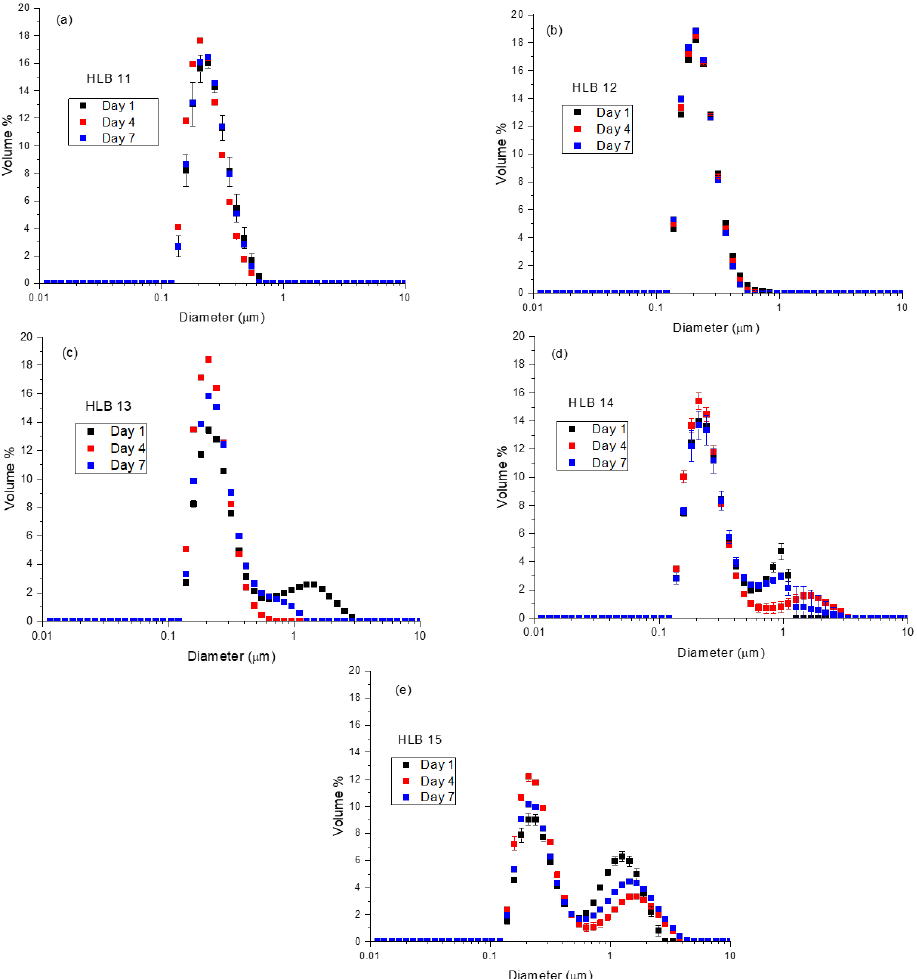
Figure 3. Droplet size distributions for emulsions with HLBs of ( a ) 11, ( b ) 12, ( c ) 13, ( d ) 14 and ( e ) 15 as a function of aging time.